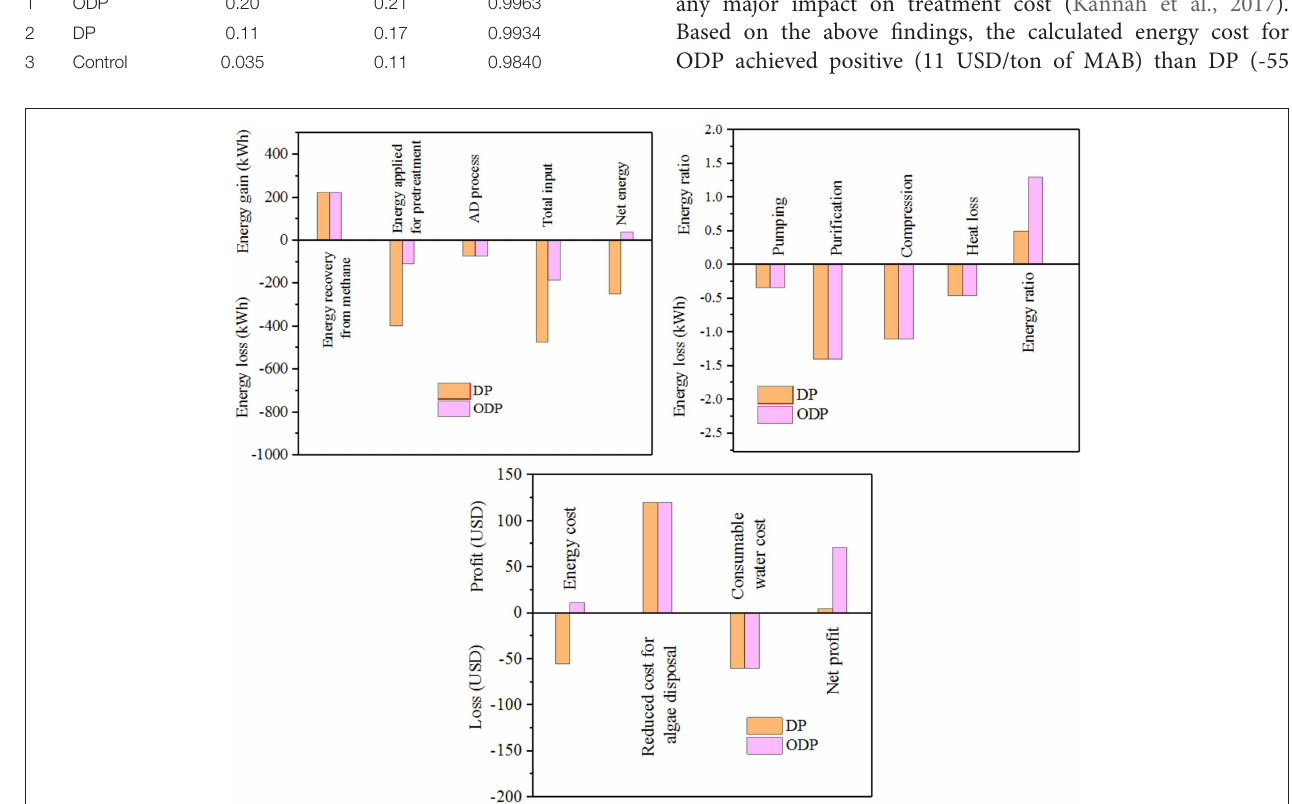
FIGURE 6 | Effect of DP, ODP samples on energy balance, and cost assessment.